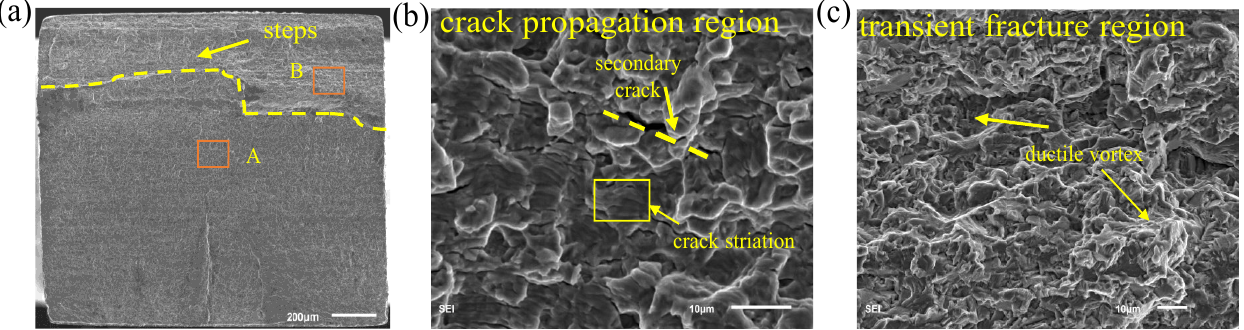
Figure 11. Fractography of sample failed by bending: ( a ) Pure bending (σ a = 335 MPa, N f = 1.47 × 10 8 ) crack morphology; ( b ) enlarged image of area A crack propagation region); ( c ) enlarged image of area B (transient fracture region).